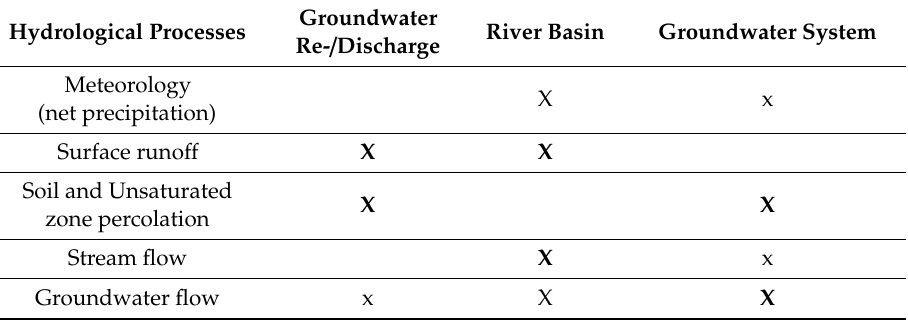
Table 2. Natural hydrological processes in the freshwater cycle a ff ecting urban planning (capital bold letters indicate impact magnitude). Groundwater River Basin Groundwater Hydrological Processes Re- / Discharge